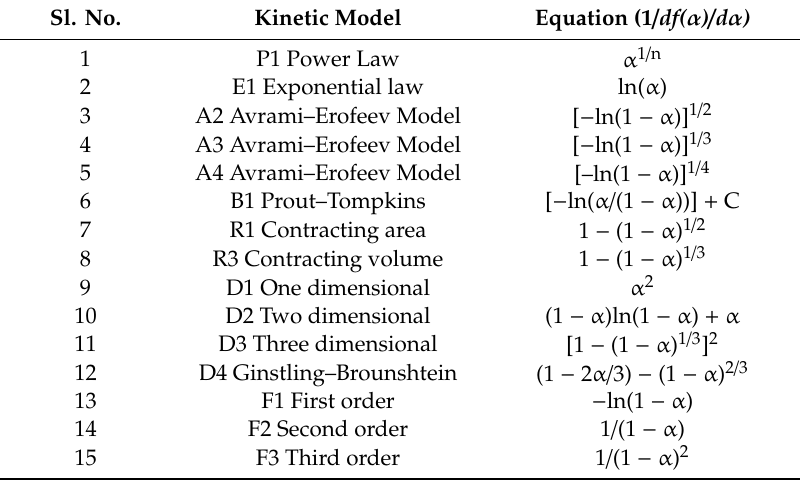
Table 1. Governing Equations of the Various Kinetic Models Employed in the Software. Sl.